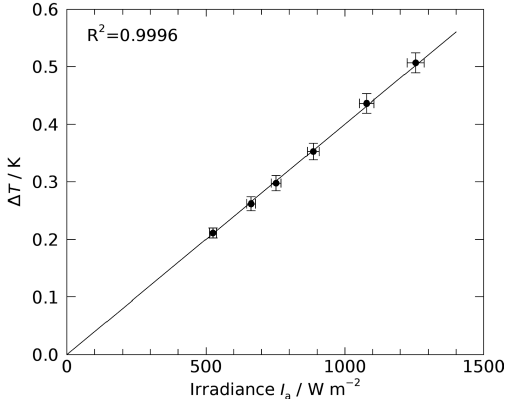
Figure 7. Dependence of sensor warming on radiative flux, mea- sured at a pressure of 30hPa, ventilation speed of 5ms − 1 , inci- dence angle 45 ◦ , and rotation period